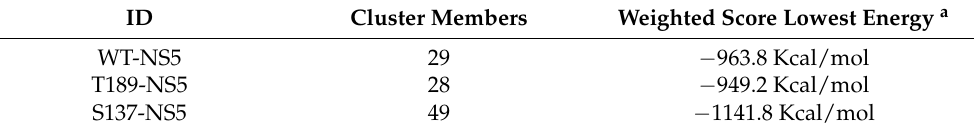
Table 6. NS3–NS5 docking